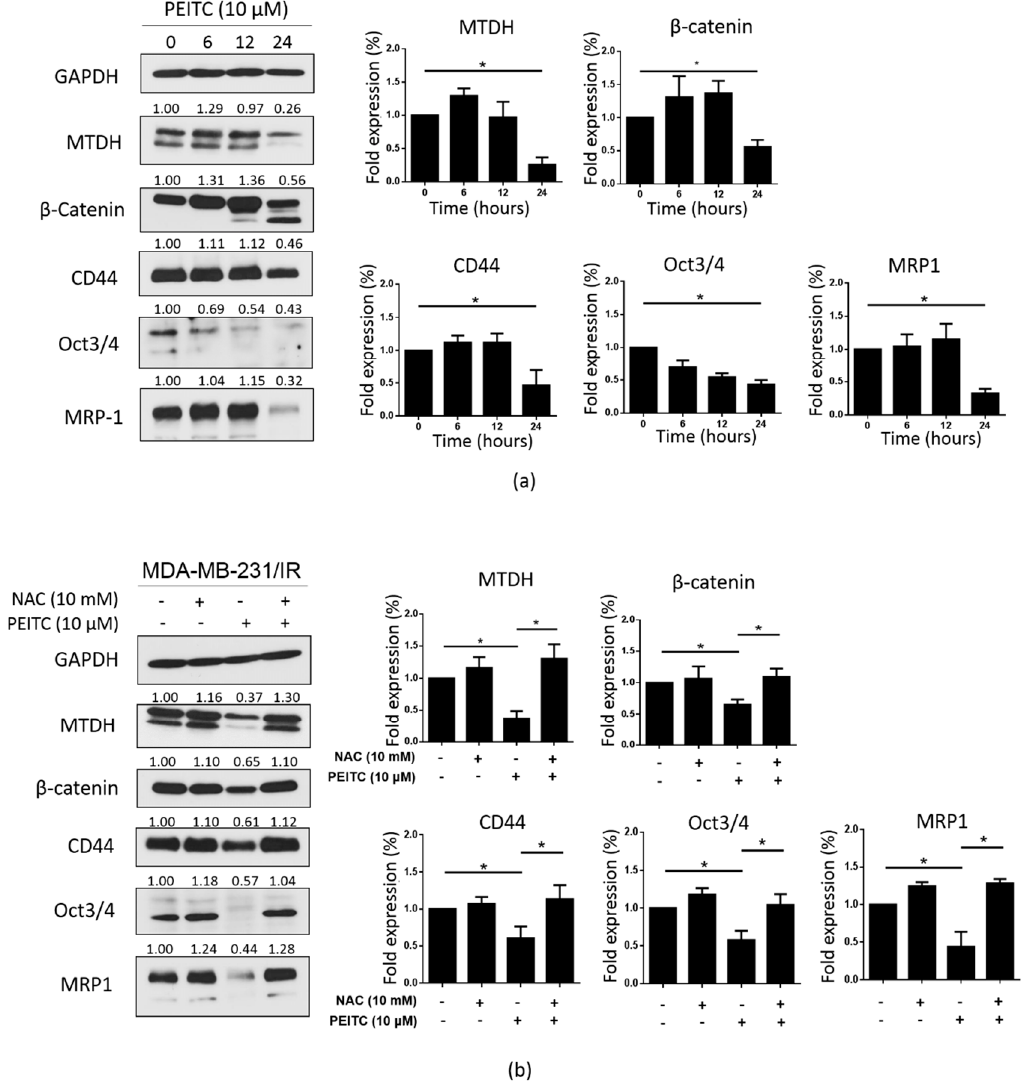
Figure 7. PEITC targets MTDH and CSC markers in MDA-MB-231 / IR cells. ( a ) The levels of MTDH and CSC markers were assessed by Western blotting following PEITC (0, 10 µ M) treatment. ( b ) NAC pre-treatment helped maintain the expression of MTDH and CSC markers; * p < 0.05; results are presented as mean ± standard deviation.